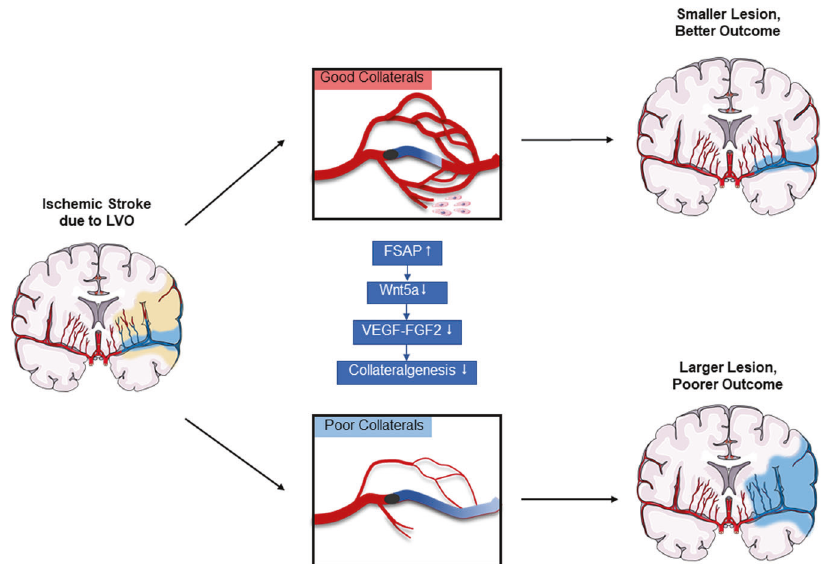
Fig. 8 Take home fi gure. Plasma FSAP levels signi fi cantly increased in patients with AIS due to LVO and poor collaterals, and correlates with neurological outcome. Pathological expression of FSAP was validated in an experimental stroke model, and negatively associated with pro- angiogenic vascular factors. Suppression of FSAP enhances revascularization, improves the integrity of brain blood barrier, and promotes newly formed microvessels in the penumbral area of ischemic brains, and consequently decreased infarct size and neurological de fi cit. Mechanistic analysis revealed FSAP might facilitate endothelial dysfunction by regulating Wnt5a